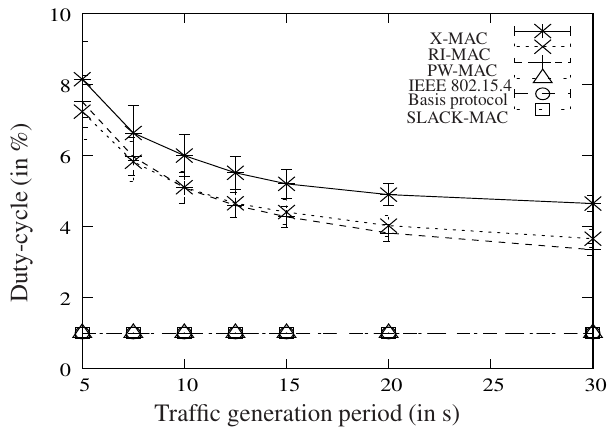
Figure 8. Duty-cycle as a function of the traffic generation period, for a duty-cycle of 1 %, and for several protocols.